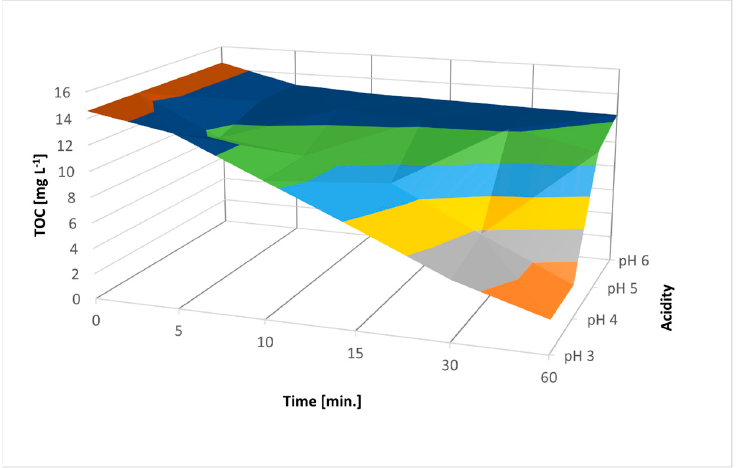
Figure 13. ANOVA results for different pH values with optimal parameters of 400 mg L − 1 H 2 O 2 and UV irradiation with 100 mg ZVI and 50 mg L − 1 AM ACID.